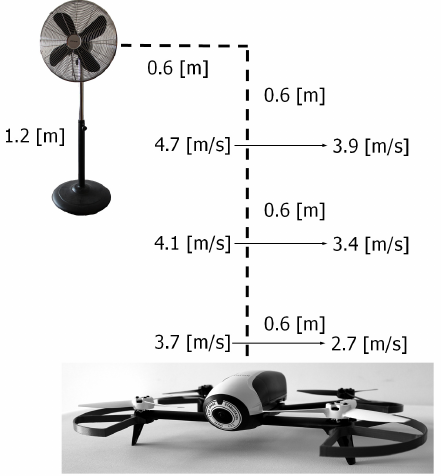
Figure 14. Test bed for research on wind gusts impact on the GLD method.